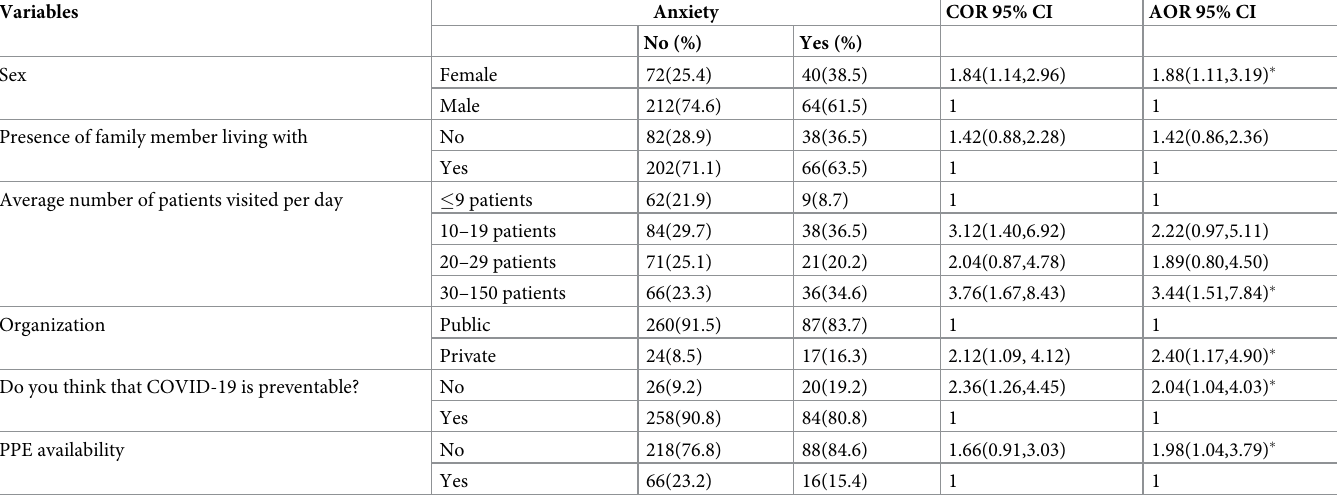
Table 2. Factors associated with anxiety among health professionals in Ethiopia during an early stage of COVID-19 pandemic (n = 388).